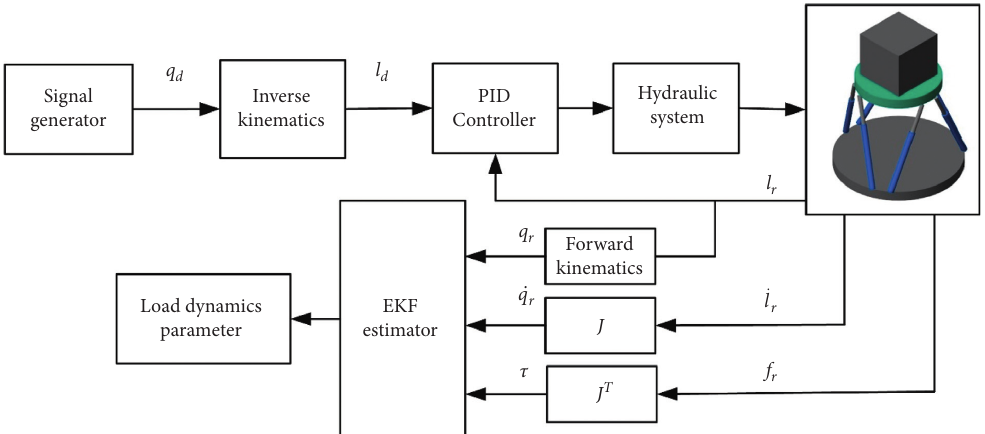
Figure 3: Load dynamic parameter identification system.